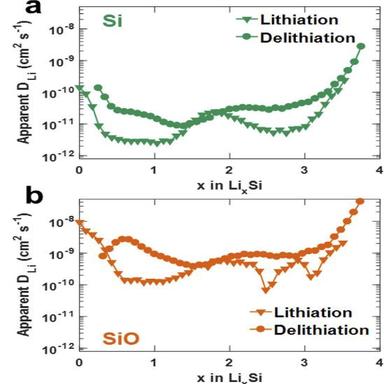
Variation in Li-diffusion coefficient of (a) Si and (b) SiO depending on Li-content (x) in LixSi measured by EIS at 25 °C.